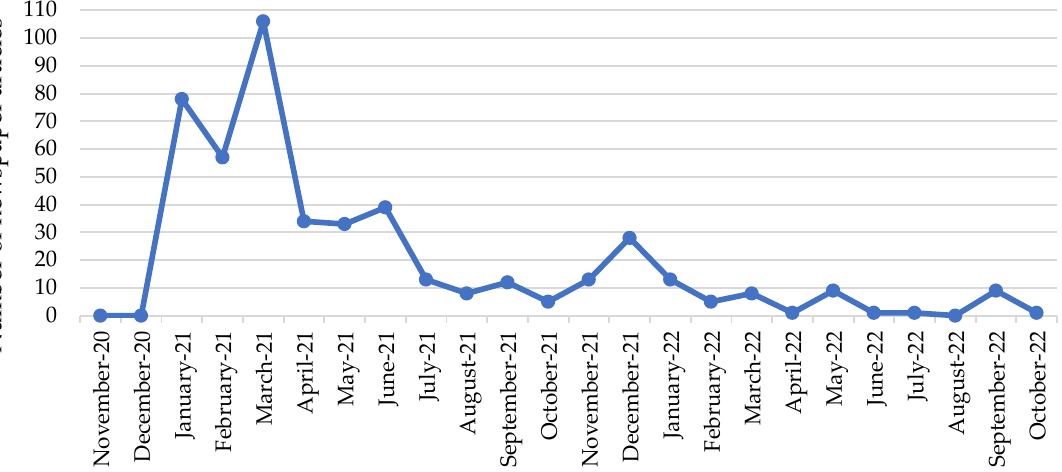
Figure 1. Number of newspaper articles mentioning Men in Black demonstrations in 10 Danish national newspapers, absolute number of articles per month, November 2020 to October 2022. Source: Infomedia. Note: Data includes the newspapers Avisen Danmark, B.T., Berlingske, Børsen, Ekstra Bladet, Information, Jyllands-Posten, Kristeligt Dagblad, Politiken, and Weekendavisen.